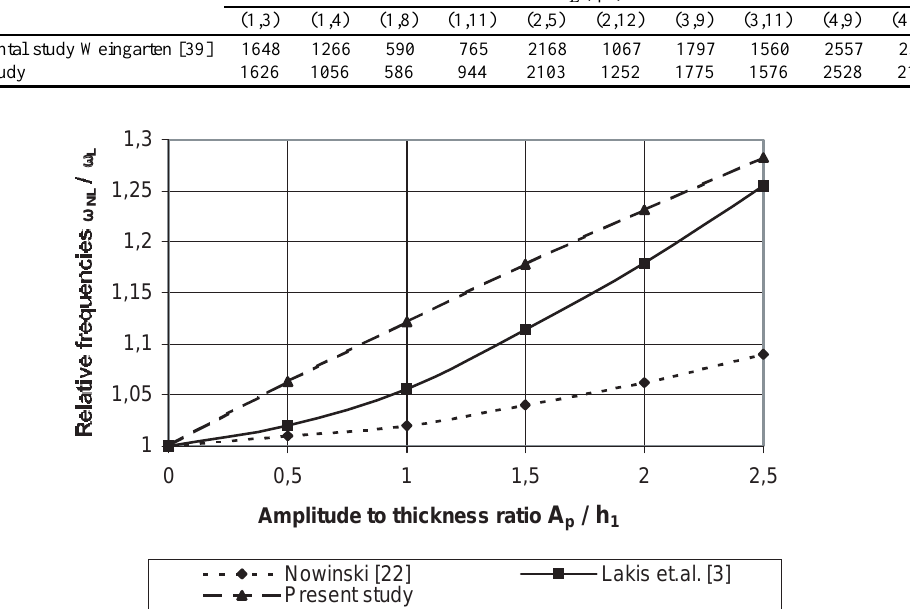
Fig. 2. Relative frequencies versus relative amplitude A p /h 1 for nonlinear vibration of an orthotropic cylindrical shell.